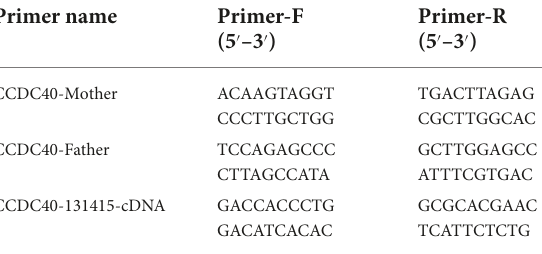
TABLE 1 Primer sequences for Sanger sequencing and minigene